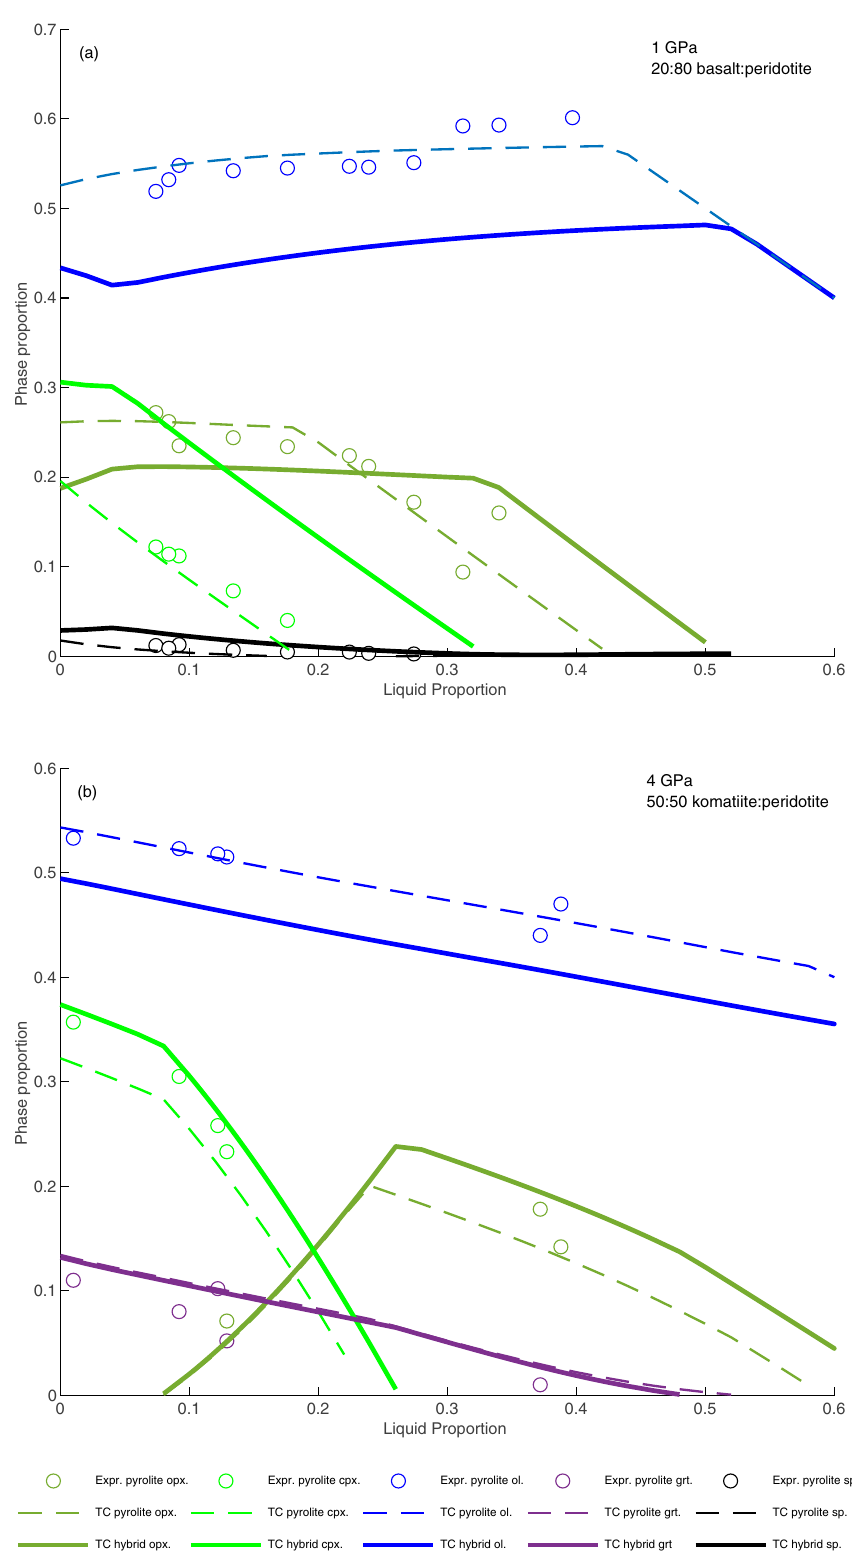
Fig. 4 Mol. proportions of residual crystalline phases ‘ vs ’ liquid fraction in the modelled melting trends. a 20:80 basalt:peridotite compared to fertile peridotite KR4003 at 1 GPa; experimental phase proportions for fertile peridotite MM3 are shown for comparison 43 ; b 50:50 komatiite:peridotite compared to fertile peridotite KR4003 at 4GPa; experimental phase proportions for fertile peridotite KR4003 are shown for comparison (open symbols 41